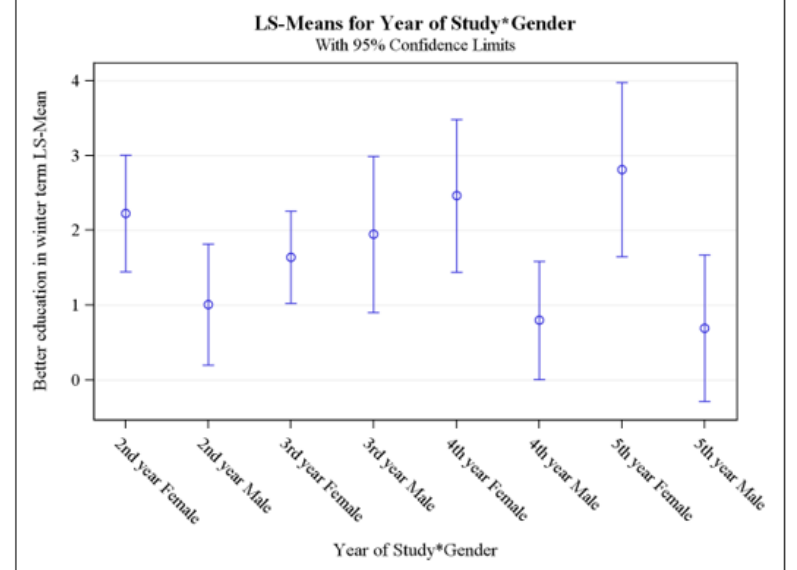
Figure 3. Point and interval estimates of LS-Means of logits for interaction of gender and year of study factors